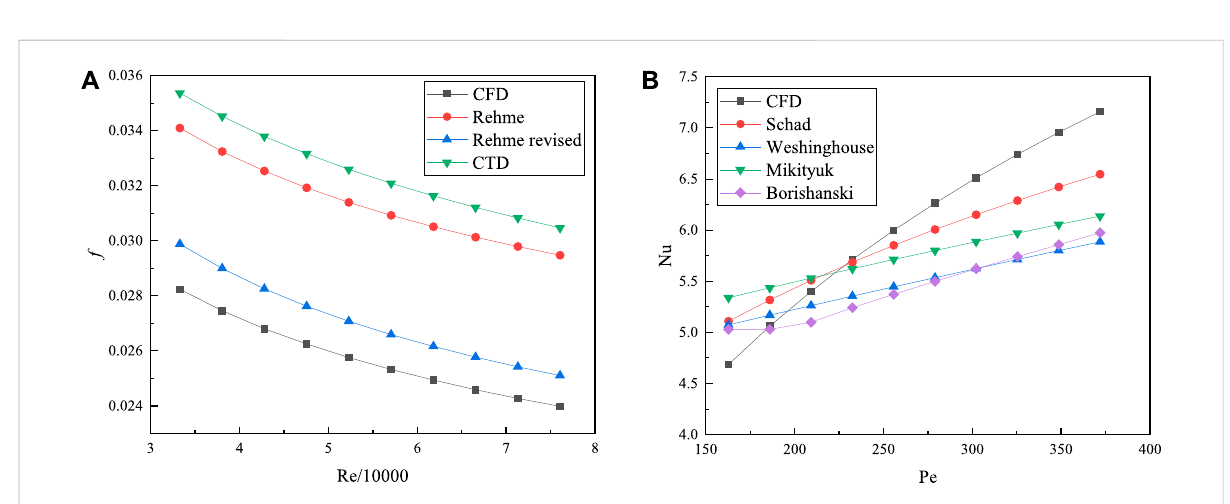
FIGURE 4 Comparison of the CFD analysis results (A) with the friction factor correlations and (B) with heat transfer